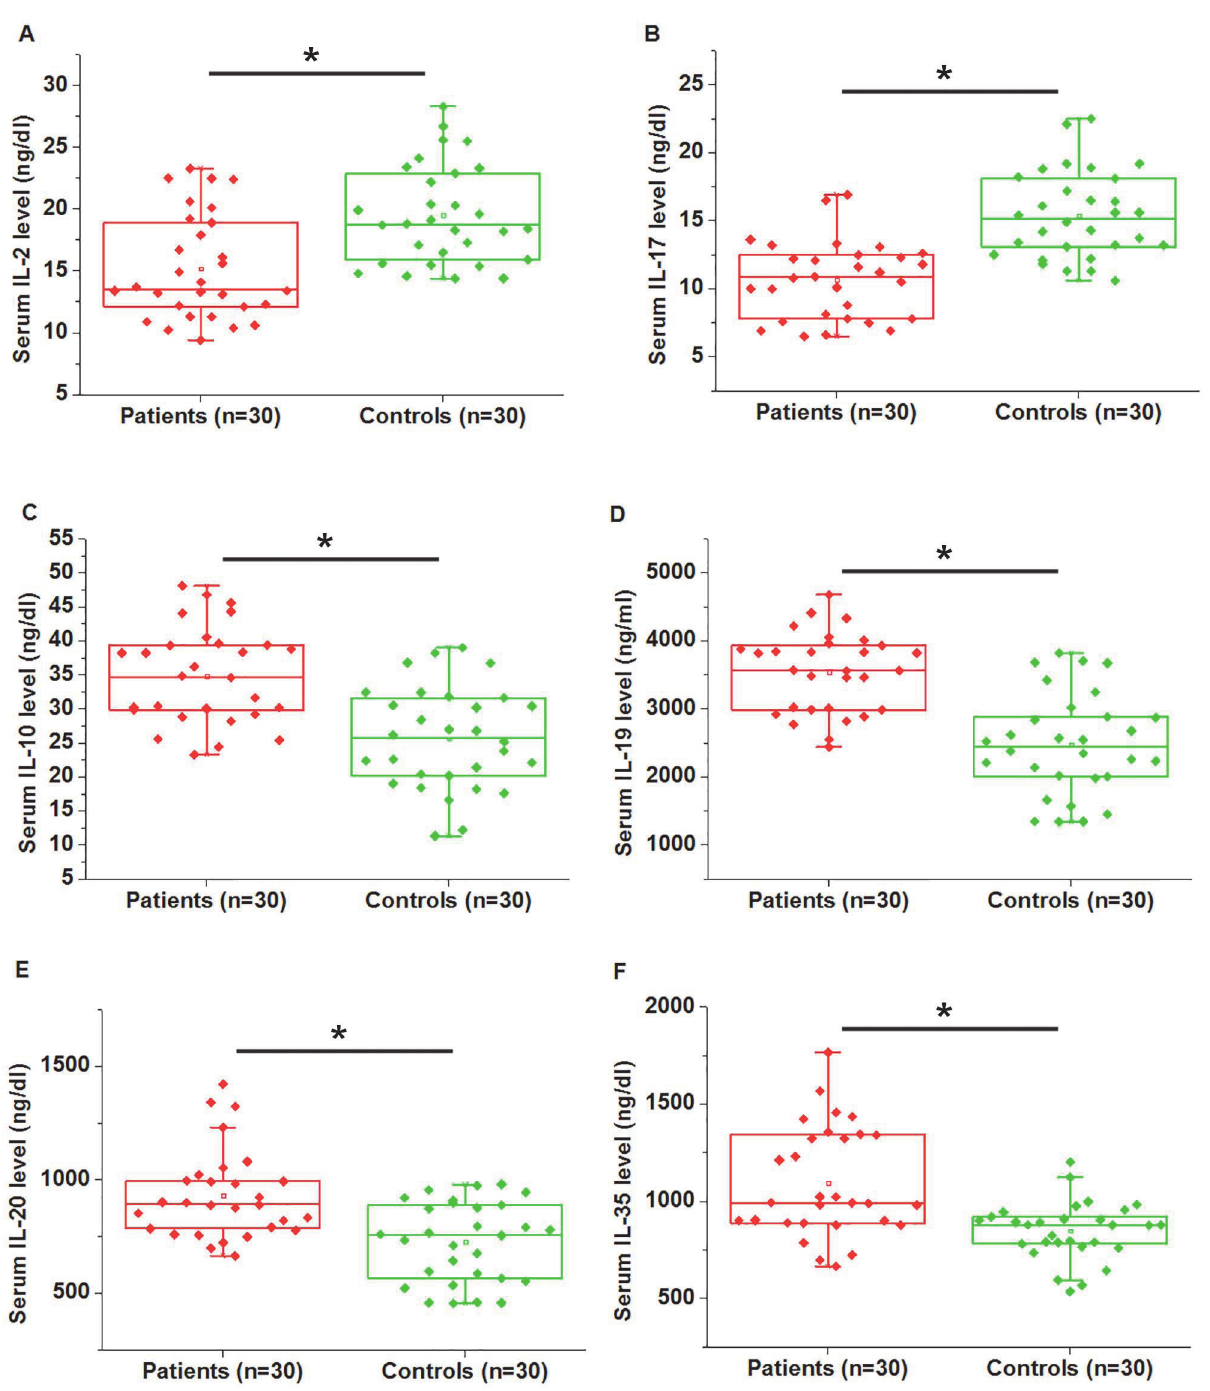
Fig. 2. Different cytokines show different expression patterns in patients with generalized myasthenia gravis. Data here show the comparison of serum levels of IL-2 (A), IL-17 (B), IL-10 (C), IL-19 (D), IL-20 (E) and IL-35 (F) between patients with generalized myasthenia gravis and healthy controls Compared with healthy controls, significantly decreased serum levels of IL-2 and IL-17 and significantly increased serum levels of IL-10 IL-19, IL-20 and IL-35 were observed in patients with generalized myasthenia gravis (*, P